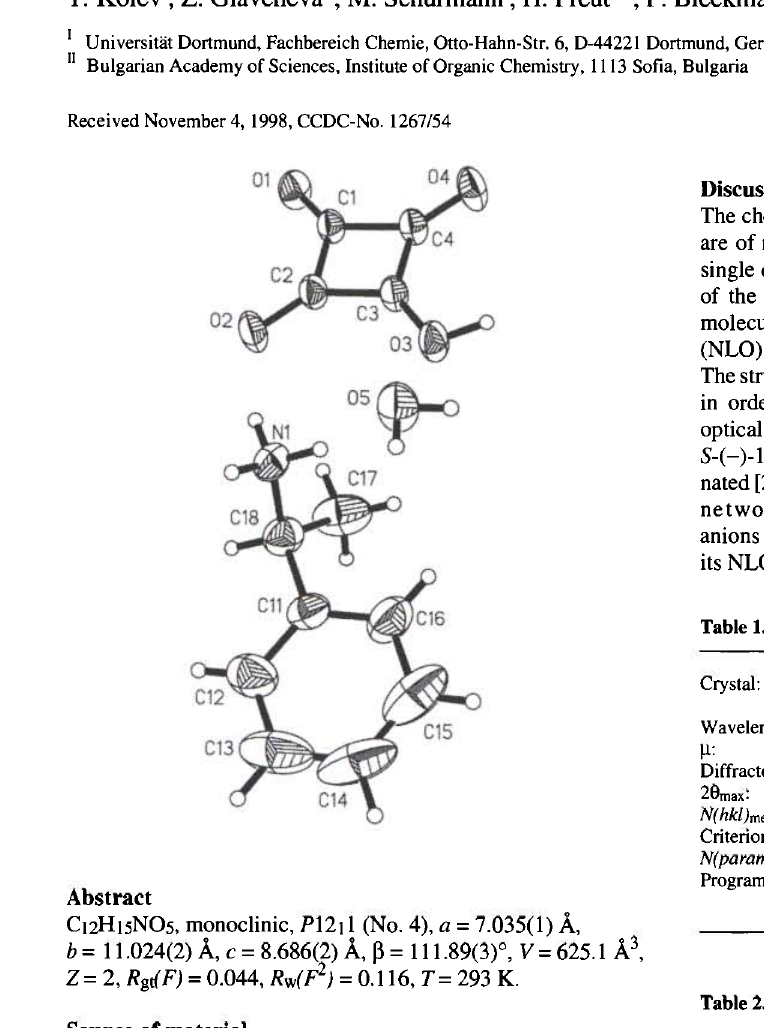
Table 2. Atomic coordinates and displacement parameters (in A 2